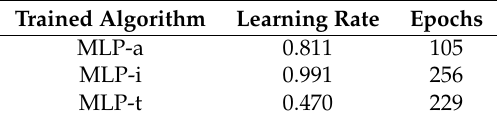
Table 9. MLP parameter tuning results.